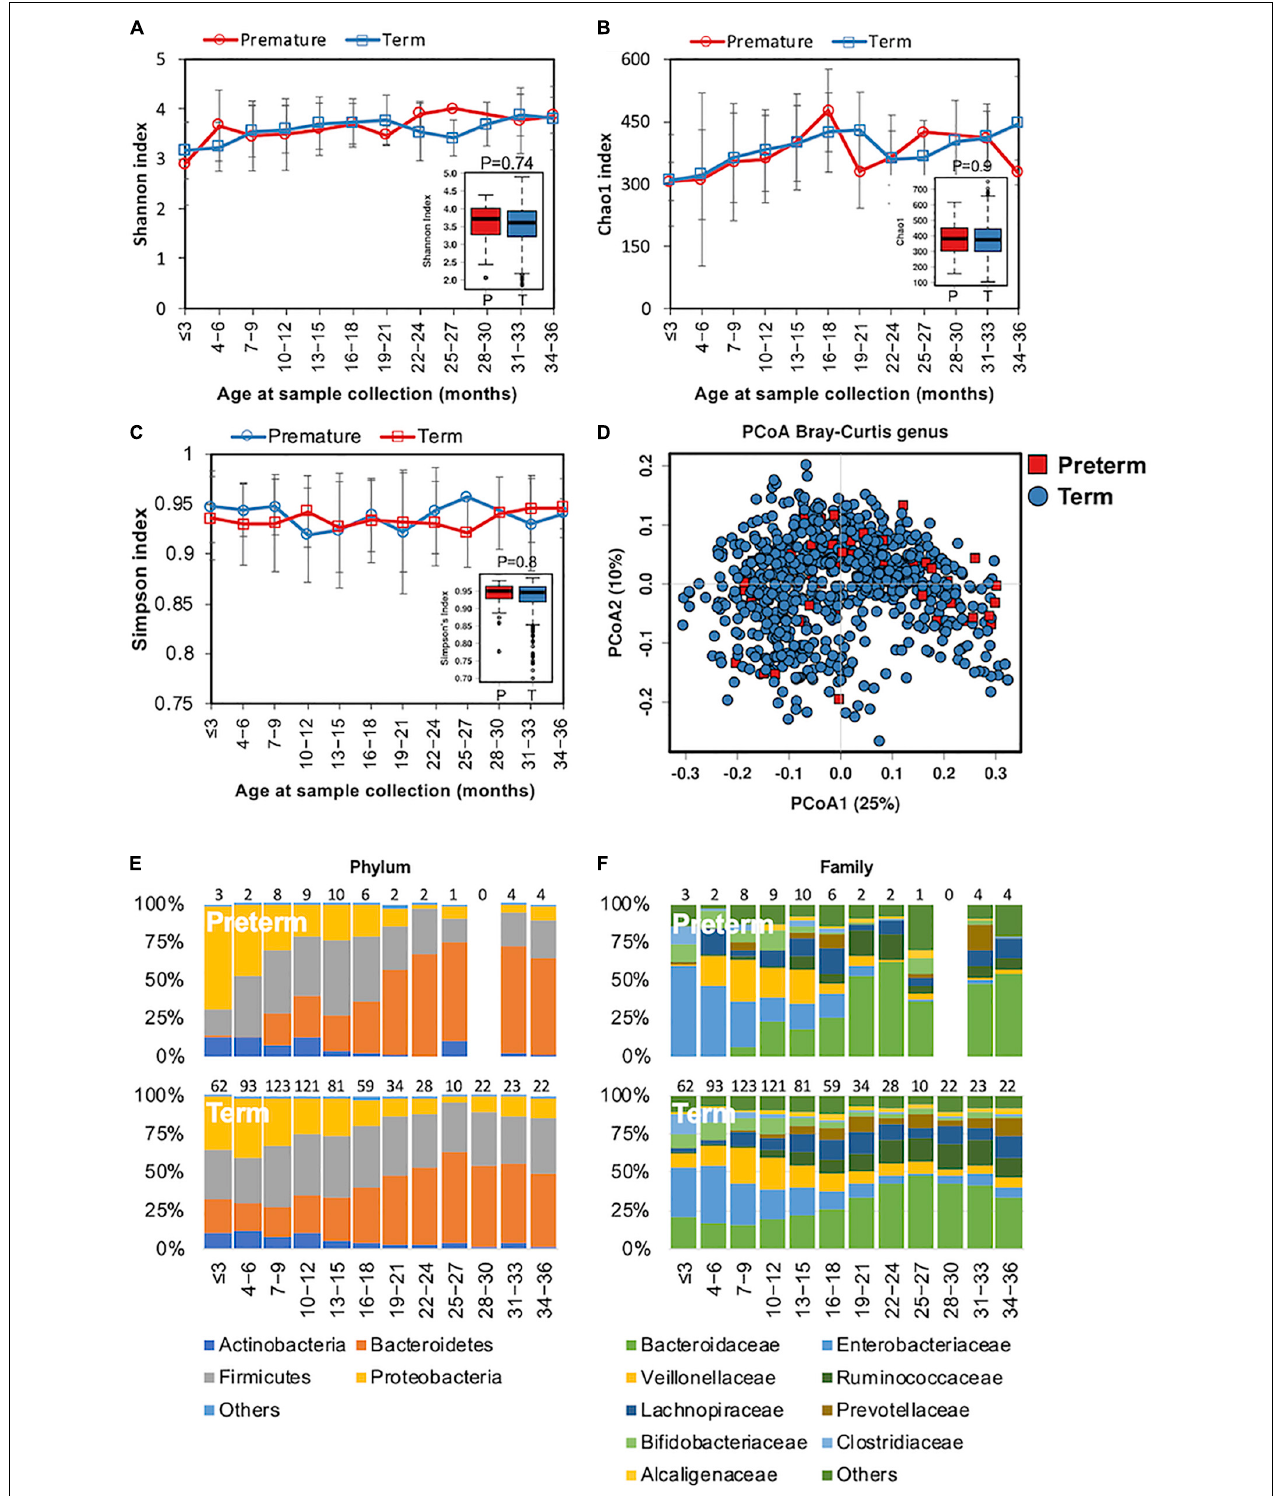
FIGURE 3 | Fecal microbiota diversity and composition for 729 children according to gestational age. Alpha diversity was calculated with (A) Shannon index, (B) Chao1, and (C) Simpson’s index, and showed no significant difference between premature and full-term children. (D) PCoA showed no clear separation between samples from premature and full-term children. Gestational age-stratified taxa summary composition of bacterial microbiota at the (E) phylum and (F) family levels. Number of children per age group is provided above bars.